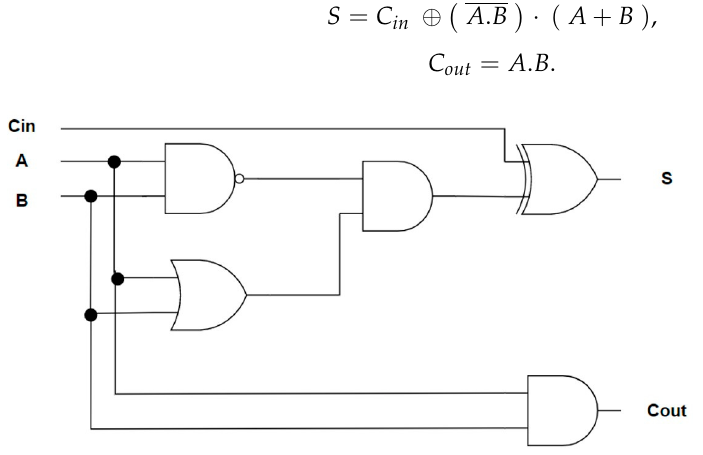
Figure 6. Carry-Predicting Full Adder (CPredA).